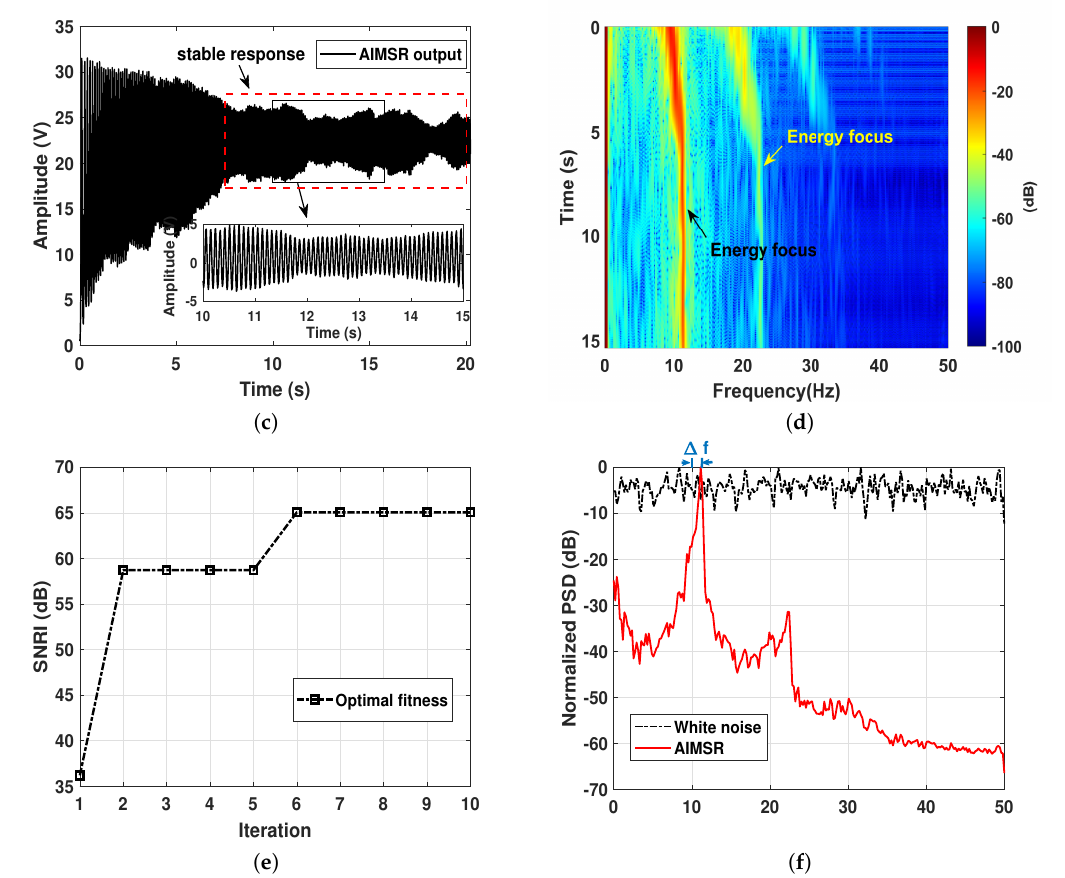
Figure 5. A simulation of a harmonic-related line signature signal on H 1 assumption: ( a ) the input waveform and its normalized power spectrum; ( b ) lofargram obtained with the input; ( c ) the AIMSR output waveform ( γ opt = 0.0462, K opt = 159.2903, h opt = 0.5763); ( d ) lofargram obtained with the AIMSR output; ( e ) the optimal fitness at each iteration with GA; ( f ) filtering performance